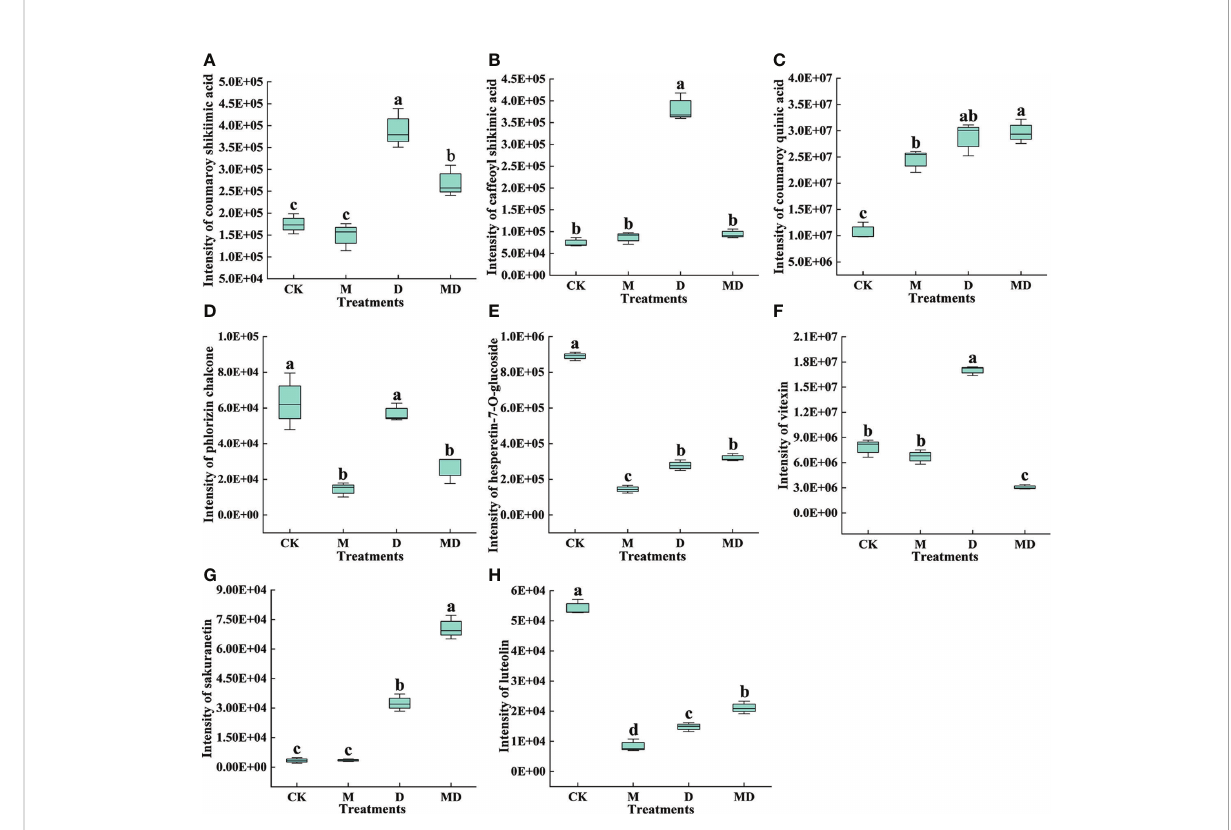
FIGURE 6 Effects of exogenous MT on DEMs in the fl avonoid biosynthetic pathway in A. mongolicum leaves under drought stress. (A) Coumaroyl shikimate acid, (B) caffeoyl shikimic acid, (C) coumaroyl quinic acid, (D) phlorizin chalcone, (E) hesperetin-7-O-glucoside, (F) vitexin, (G) sakuranetin, (H) luteolin. Error bars represent standard errors of triplicate experiments. Mean values with different letters are signi fi cantly different at P <